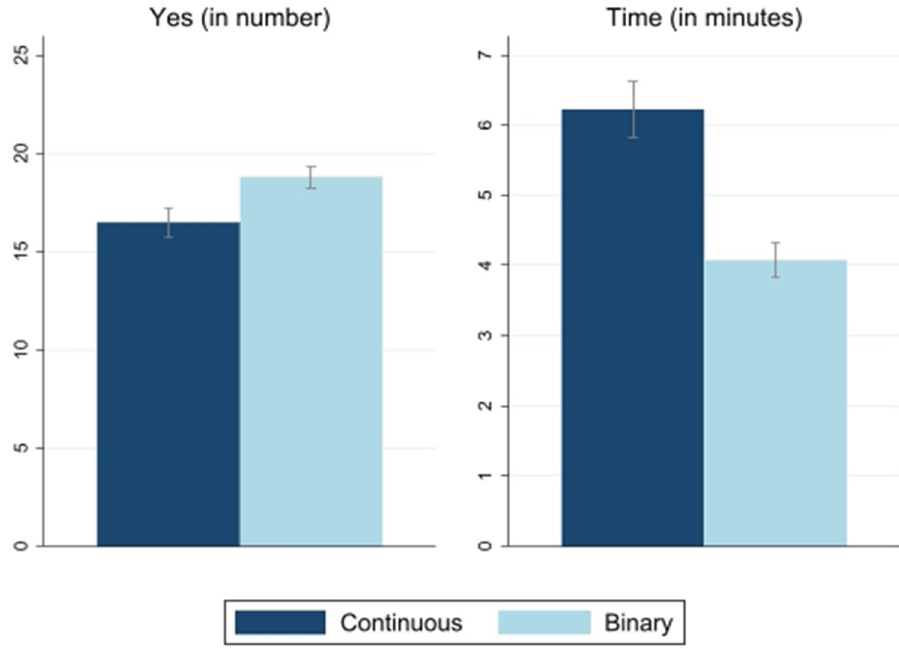
Figure 2. Binary vs. continuous settings. Left: average number of times the subjects agree in the questionnaire. Right: response time in minutes. Lines with caps represent 95% CI. Sample: all.